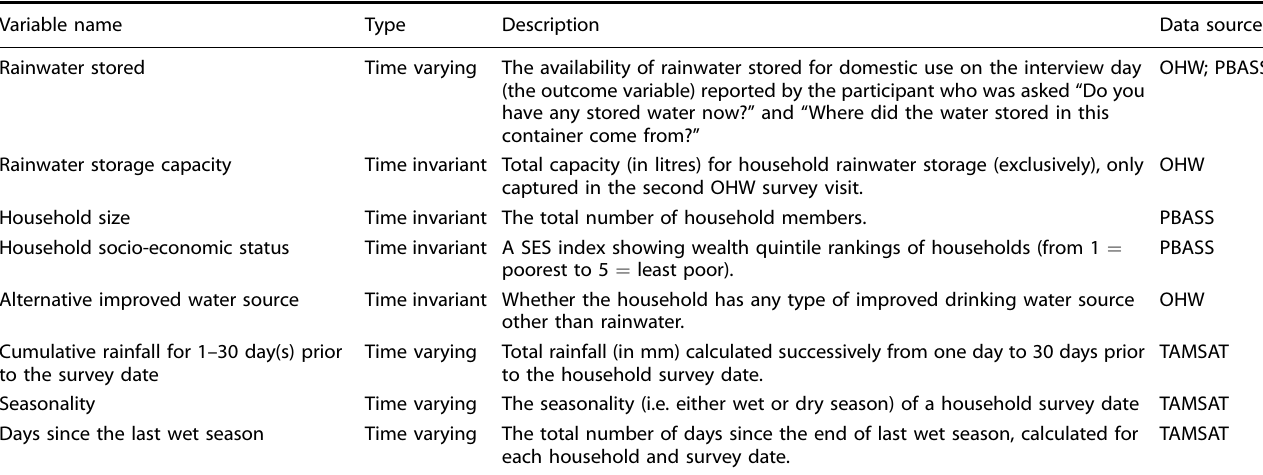
Table 3. Derived variables relevant to household use of potable rainwater